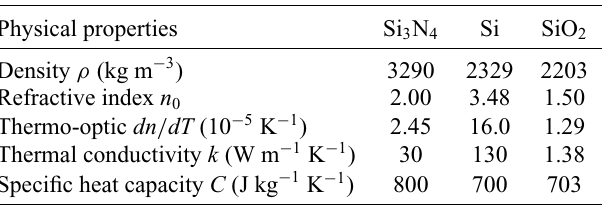
TABLE II. Physical properties used for the FEM simulations of the cavity frequency thermal